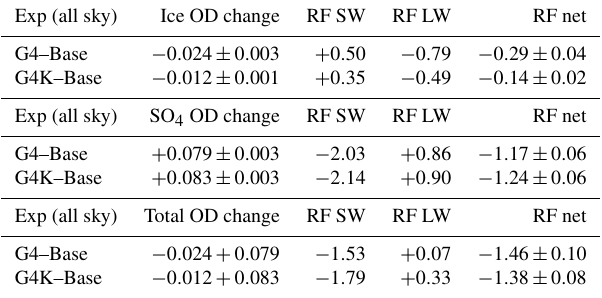
Table 3. Top three rows: globally and time-averaged values of the upper tropospheric ice optical depth changes and RF differences (Wm − 2 ) between the SG perturbed experiments and the RCP4.5 Base case due to changes in ice crystal concentration and size. Middle three rows: globally averaged values of stratospheric sul- fate aerosol optical depth changes and RF differences (Wm − 2 ) de- fined as above but due to changes in aerosol concentration and size. Bottom three rows: total OD and RF changes (i.e., ice + sulfate). All results are for all-sky conditions (i.e., including the presence of background cloudiness) and with an 8Tg-SO 2 yr − 1 injection. The RFs are calculated at the tropopause with temperature adjustment. The time is averaged over the years 2030–2069.